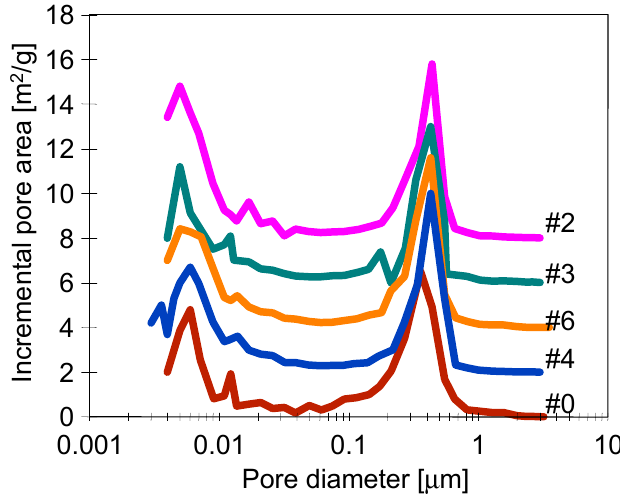
Figure 8. Pore size distribution determined by a mercury porosimetry method.